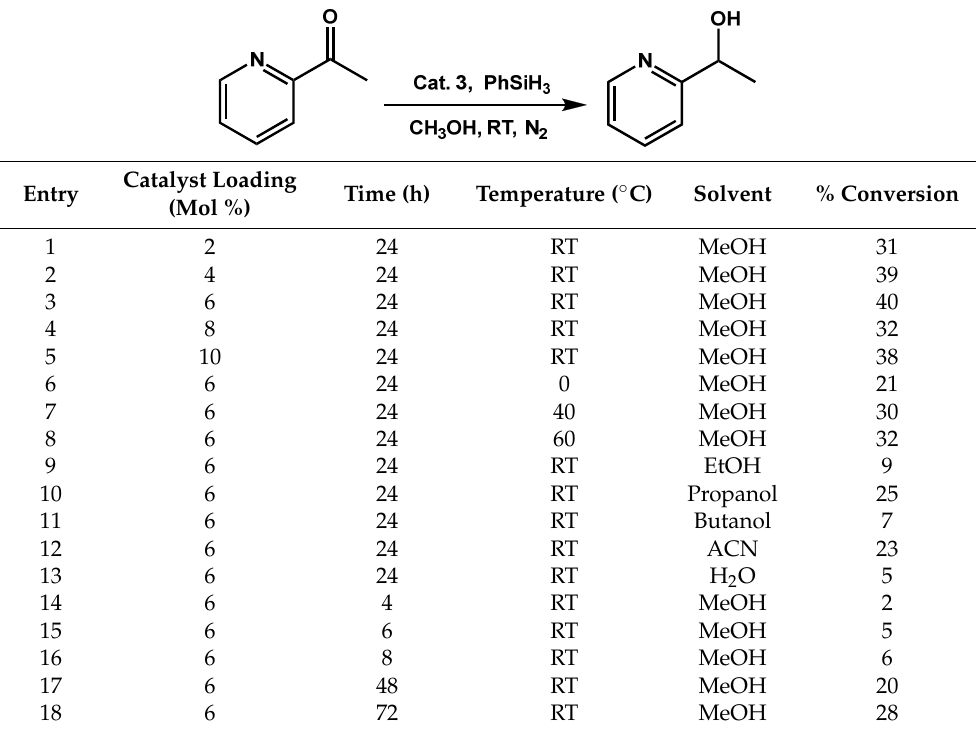
Table 2. Optimization of reaction conditions for complex 3 catalyzed formation of 1-(pyridin-2-